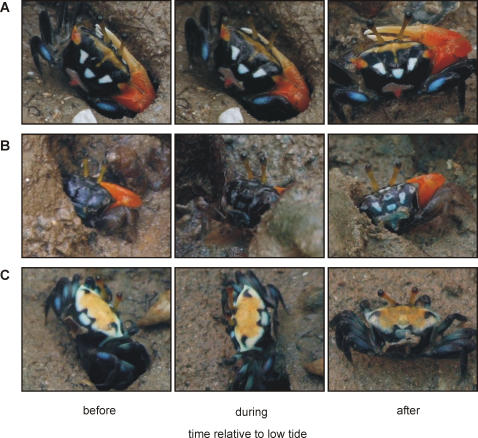
Colour changes in Uca capricornis before, during and after low tide.One male brightened primarily in the yellow scarf region (a), while the other brightened all over (b). The only female that changed colour darkened in response to an encounter with another crab after low tide (c).